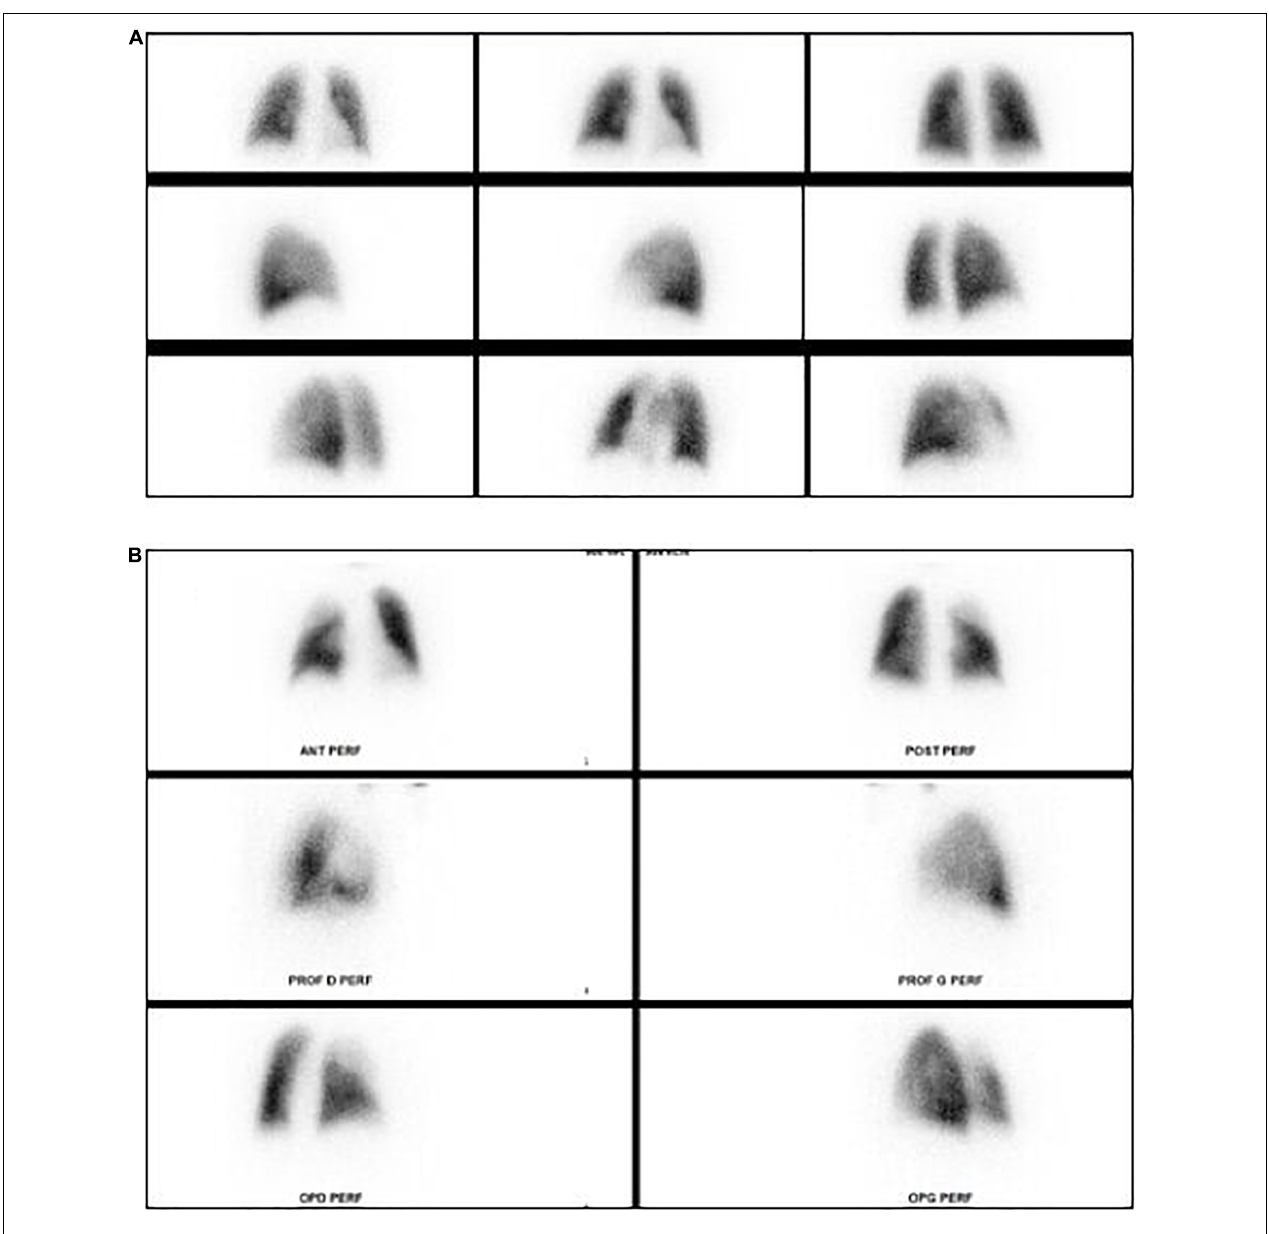
FIGURE 3 | Lung perfusion planar scintigraphy. (A) Normal lung perfusion scintigraphy. (B) Pulmonary perfusion defect in the right upper lobe in patient with pulmonary